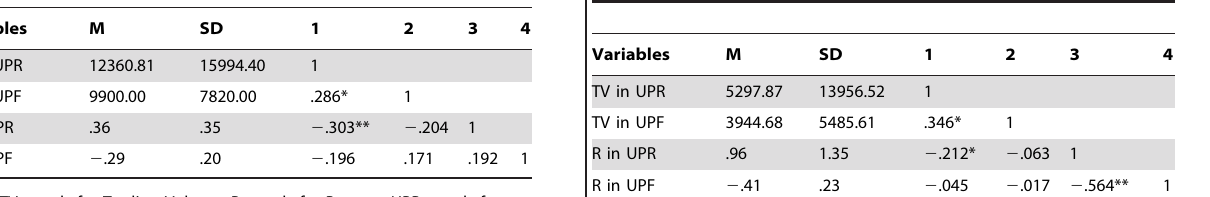
Table 2. Descriptive Statistics and Correlation Analysis of Returns and Trading Volume in an inverted treatment order